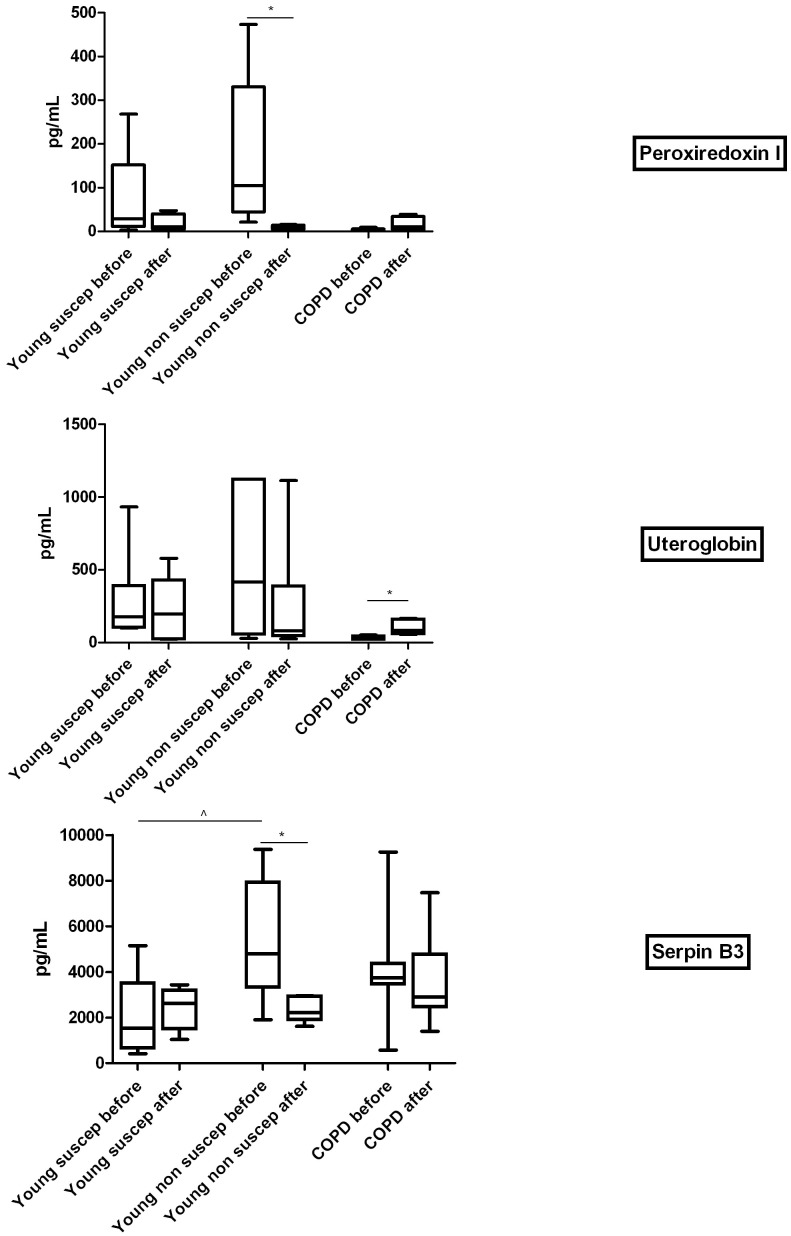
ELISA results of individual epithelial lining fluid (ELF) samples of young susceptible individuals, young non-susceptible individuals, and established COPD patients, before and after acute smoking.Results are given in box-plots with medians and interquartile ranges. *: p<0.05 before vs after smoking, ∧: p<0.05 vs young susceptible individuals at baseline.